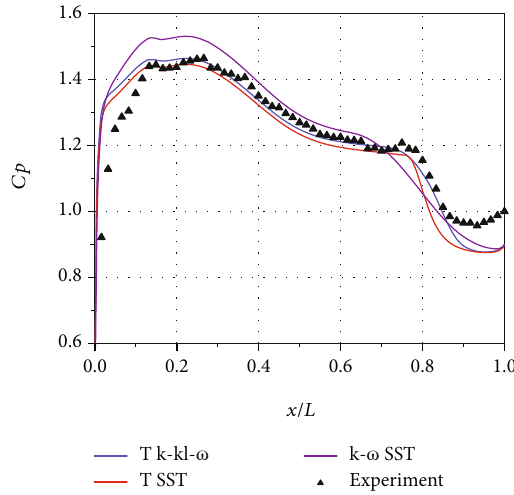
Figure 4: Turbulence model comparison in case D7-2.5 Re = 150000Tu = 0 : 65 %.